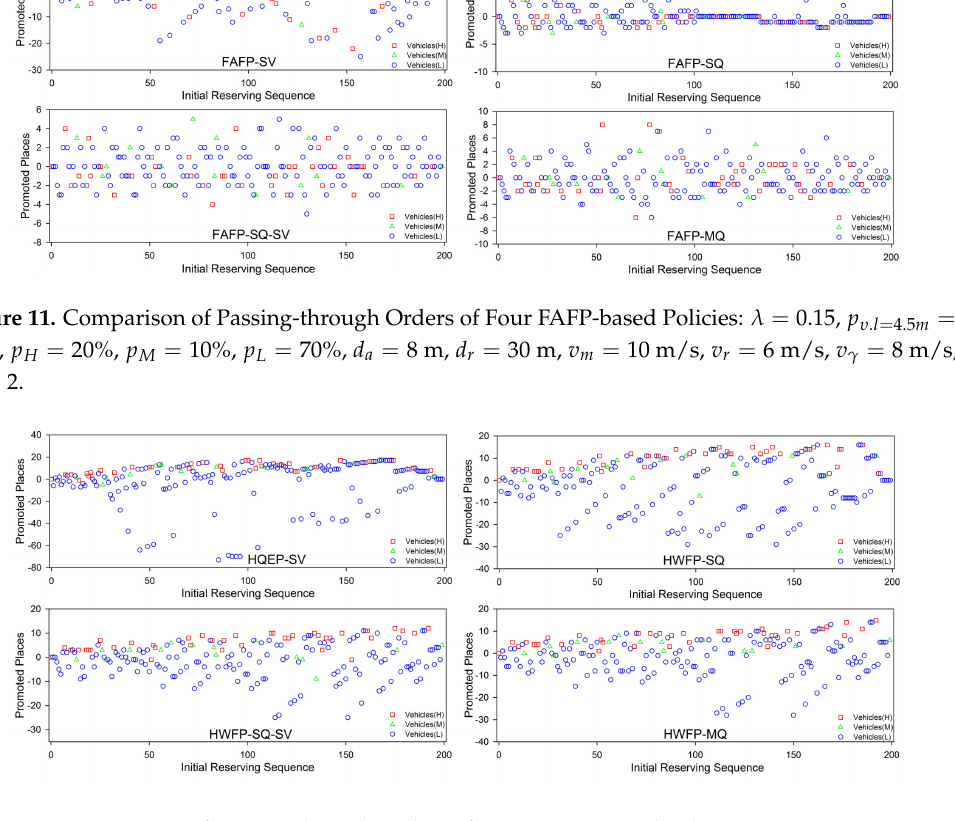
Figure 12. Comparison of Passing-through Orders of Four QoS-oriented Policies: λ = 0.15, p υ . l = 4.5 m = 30%, p H = 20%, p M = 10%, p L = 70%, d a = 8 m, d r = 30 m, v m = 10 m/s, v r = 6 m/s, v γ = 8 m/s, N =